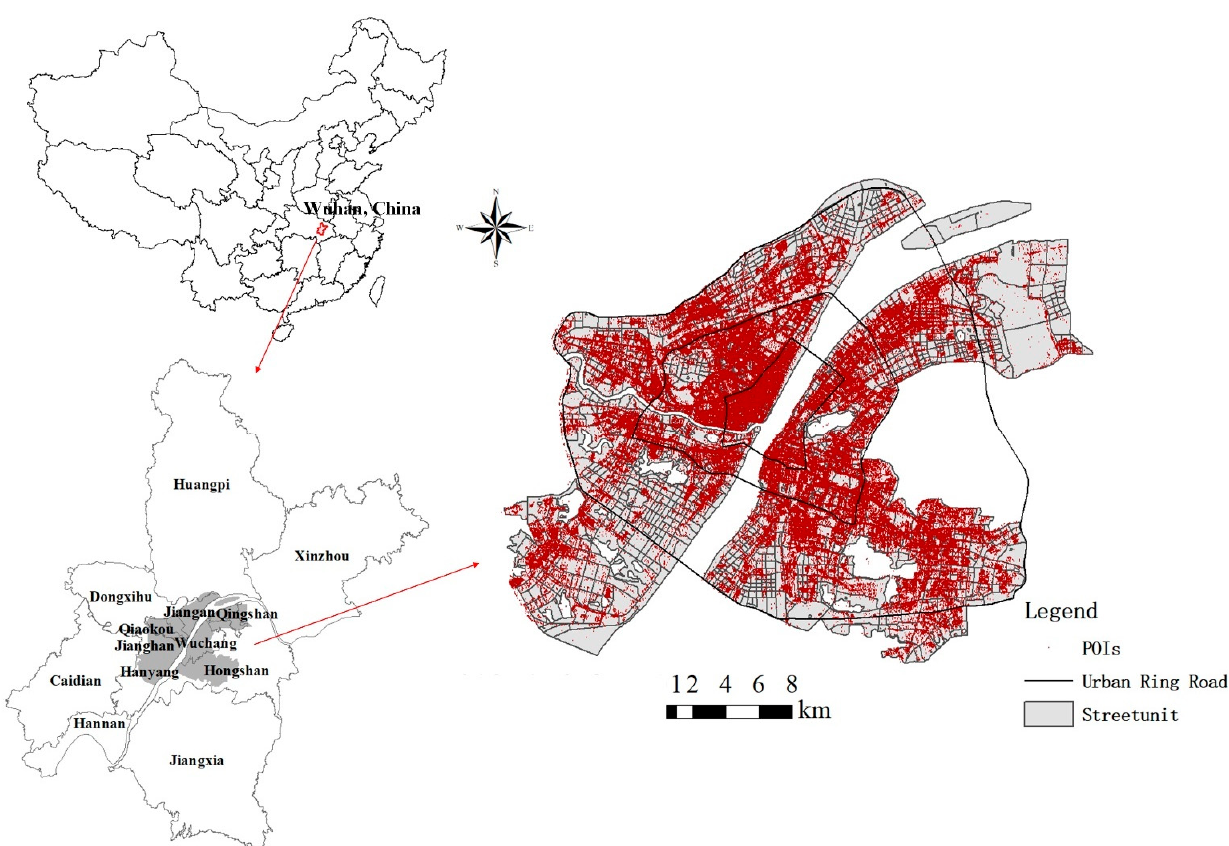
Figure 1. Location, administrative districts and POIs distribution of Wuhan. The main urban area was obtained from the Wuhan Natural Resources and Planning Bureau website (http://zrzyhgh.wuhan.gov.cn/zwgk_18/fdzdgk/ghjh/zzqgh/202001/t20200107_602858.shtml, accessed on 12 May 2017).